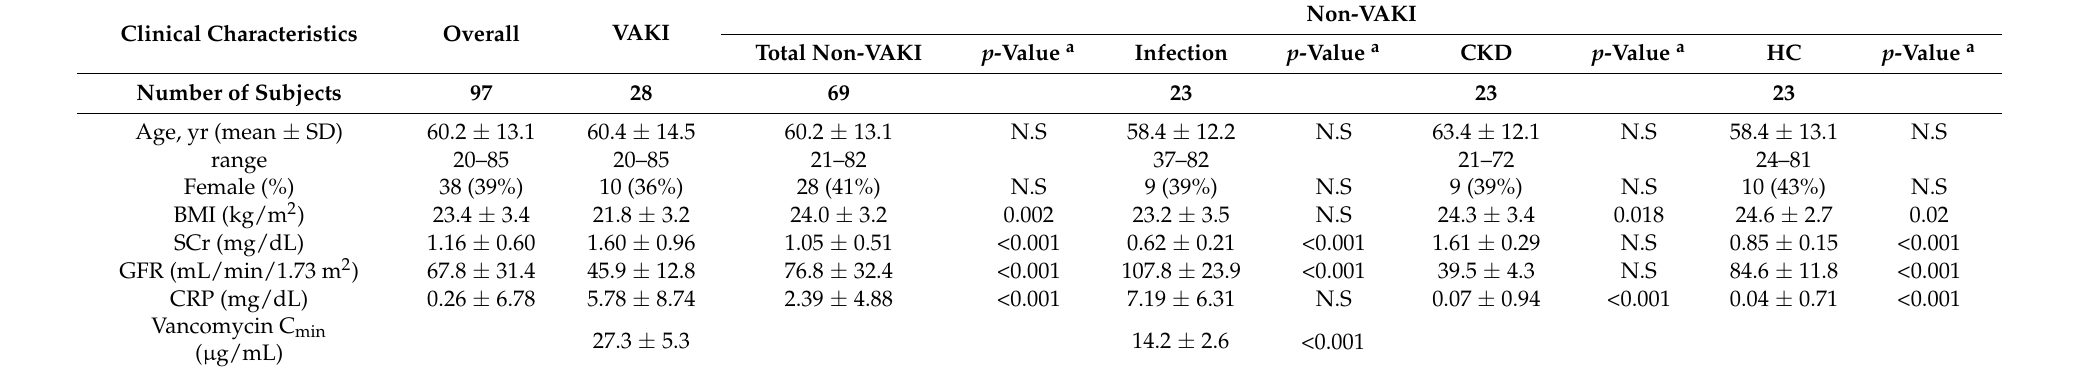
Table 1. Clinical characteristics of subjects in this study.